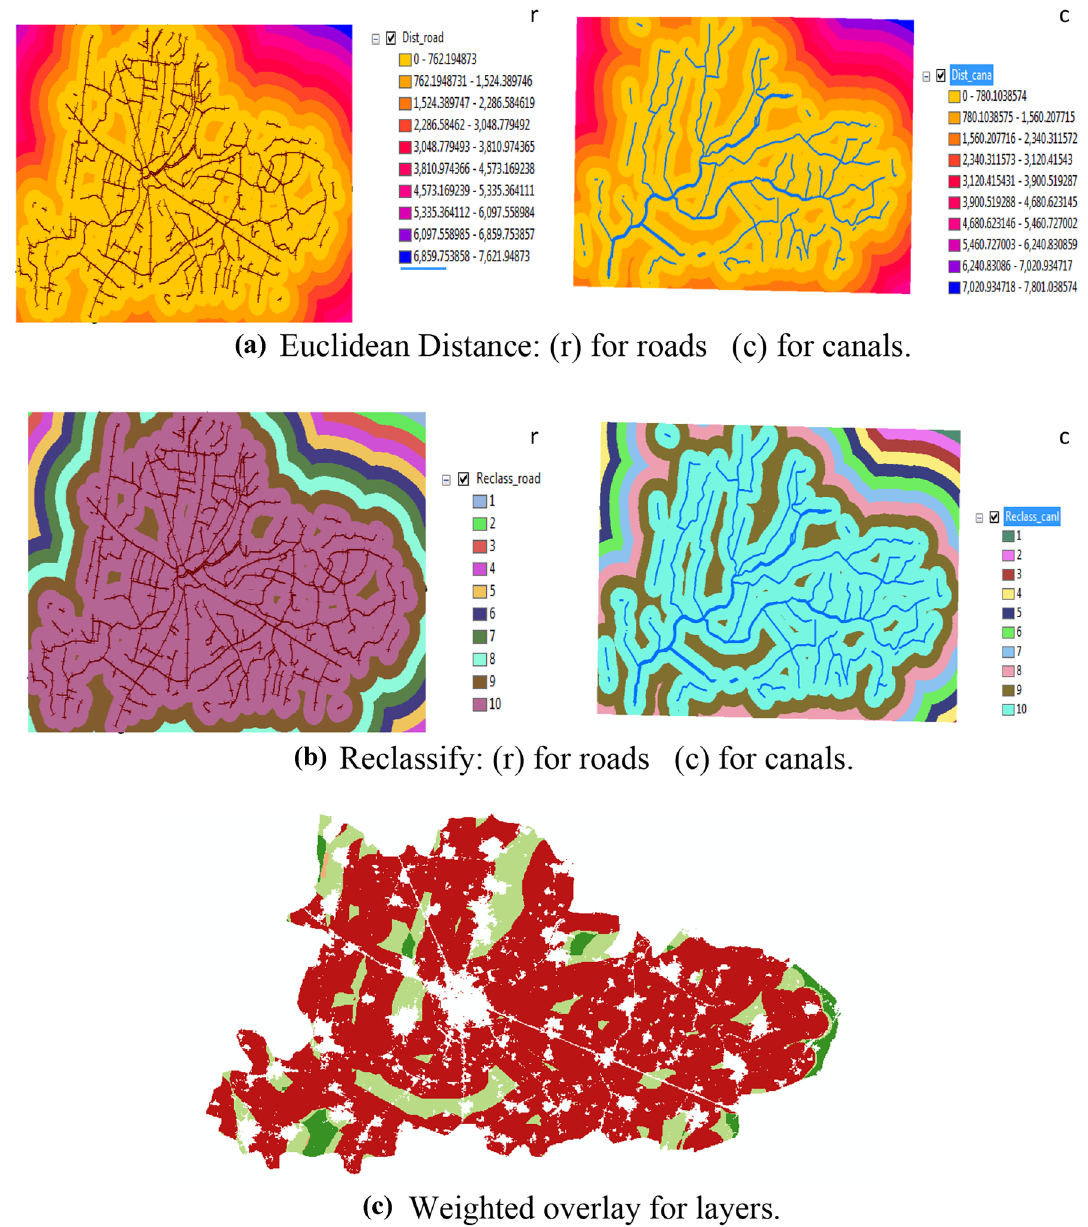
Figure 5. (a) Euclidean Distance: (r) for roads (c) for canals. (b) Reclassify: (r) for roads (c) for canals. (c) Weighted overlay for